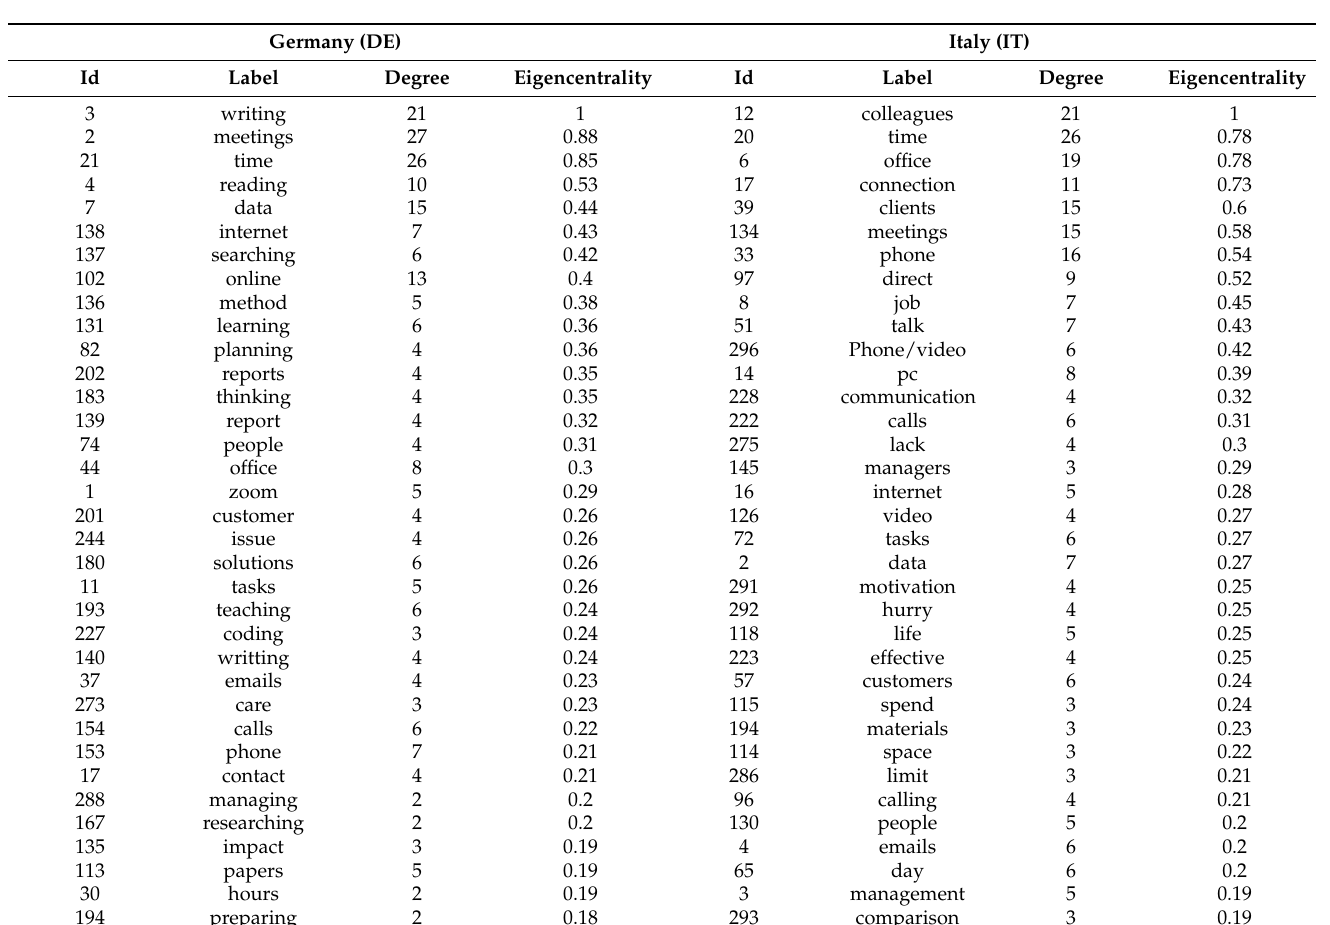
Table 3. Summary Output of the Semantic Network